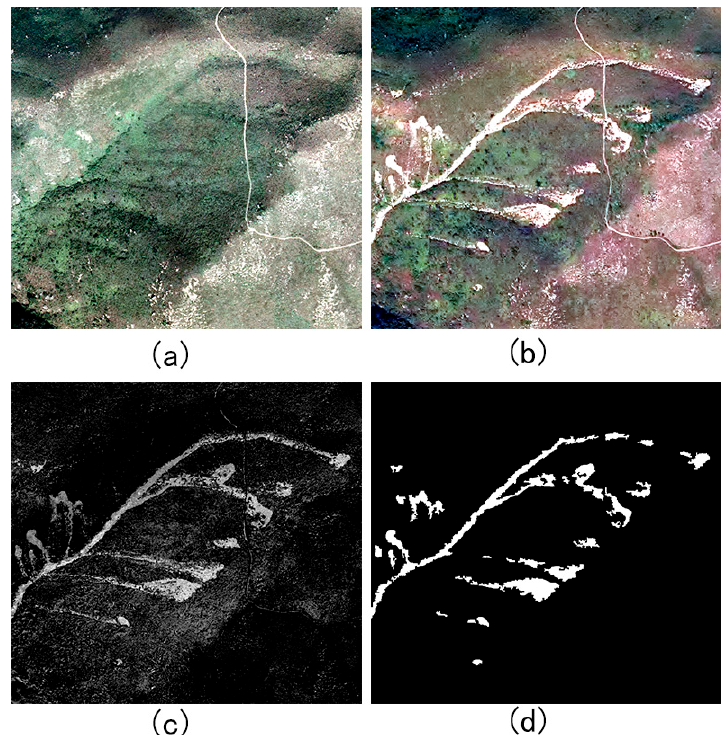
Figure 8. First dataset: Digital Orthophoto Map acquired by an aerial plane in: ( a ) April 2007; and ( b ) July 2014; ( c ) corresponding change magnitude image (CMI) generated through the difference method; and ( d ) reference of the changed area caused by the landslide.